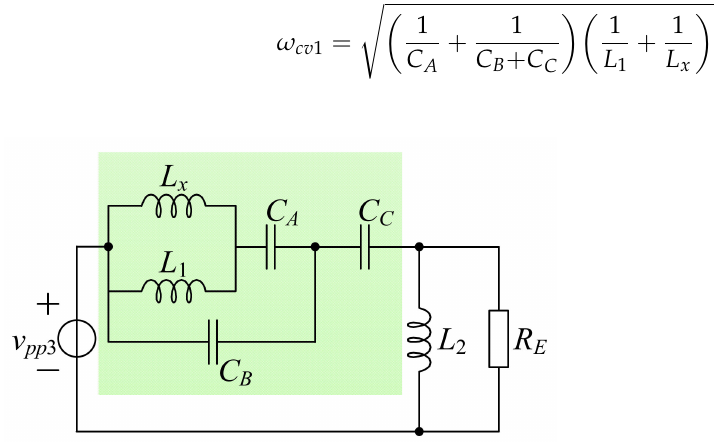
Figure 13. The simplified L x -PP CPT circuit using the T-type model to realize CV output.